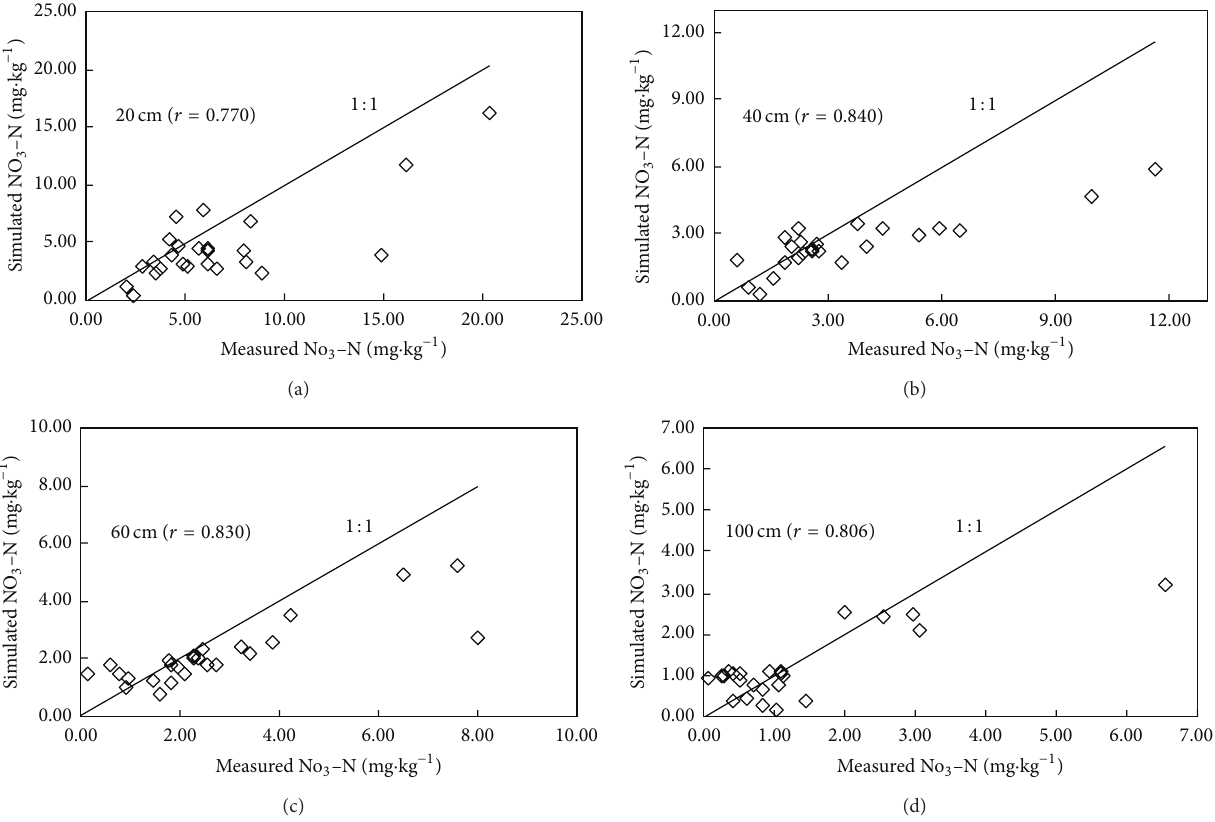
Figure 5: Comparison between simulated values and measured values of NO 3 -N with different soil layer in conventional planted farmland.